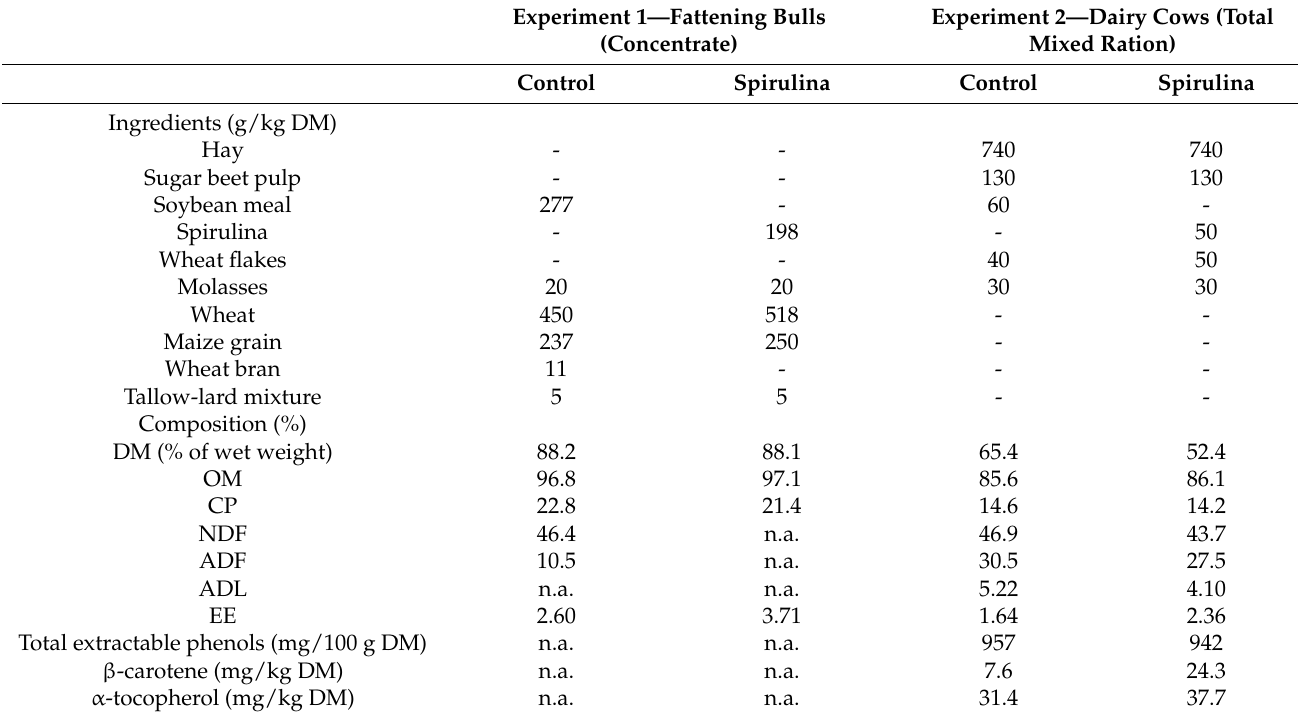
Table 1. Components of the experimental concentrate used in experiment 1 (fattening bulls) and the experimental total mixed ration used in experiment 2 (dairy cows), their chemical composition and contents of extractable phenols, β -carotene, and α -tocopherol. Experiment 1—Fattening